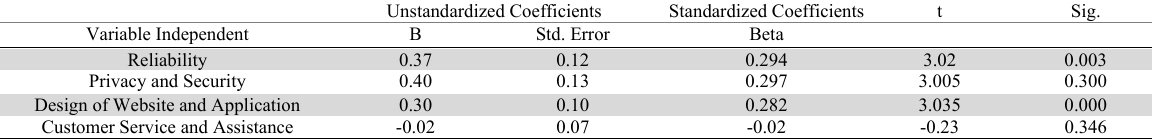
The results of regression